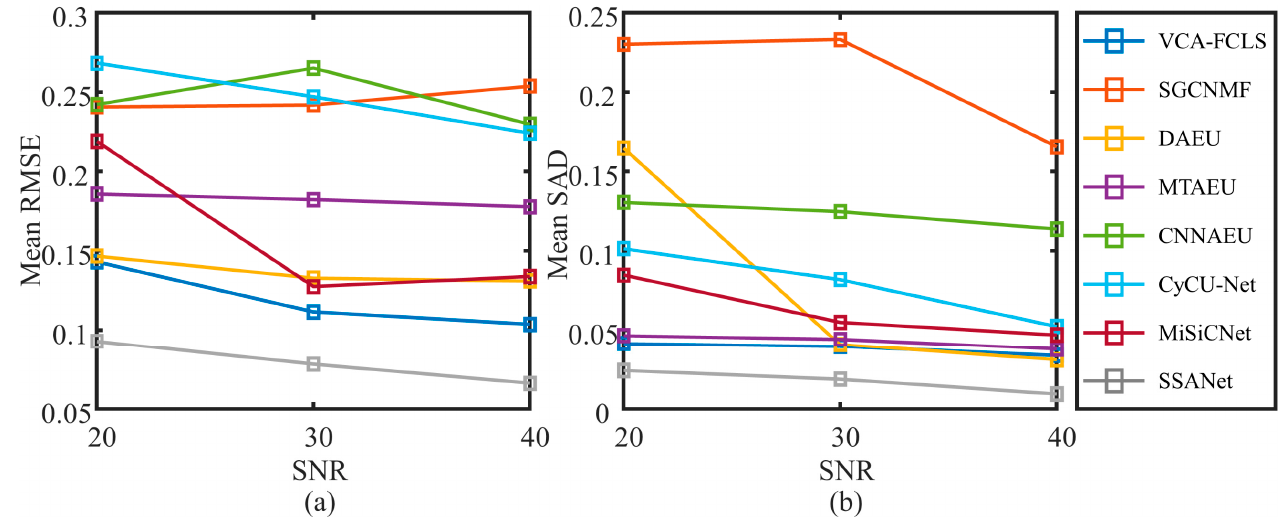
Figure 8. Experimental results of SSANet with various noise values (20, 30, and 40 dB) for the synthetic dataset. ( a ) Mean RMSE. ( b ) Mean SAD.